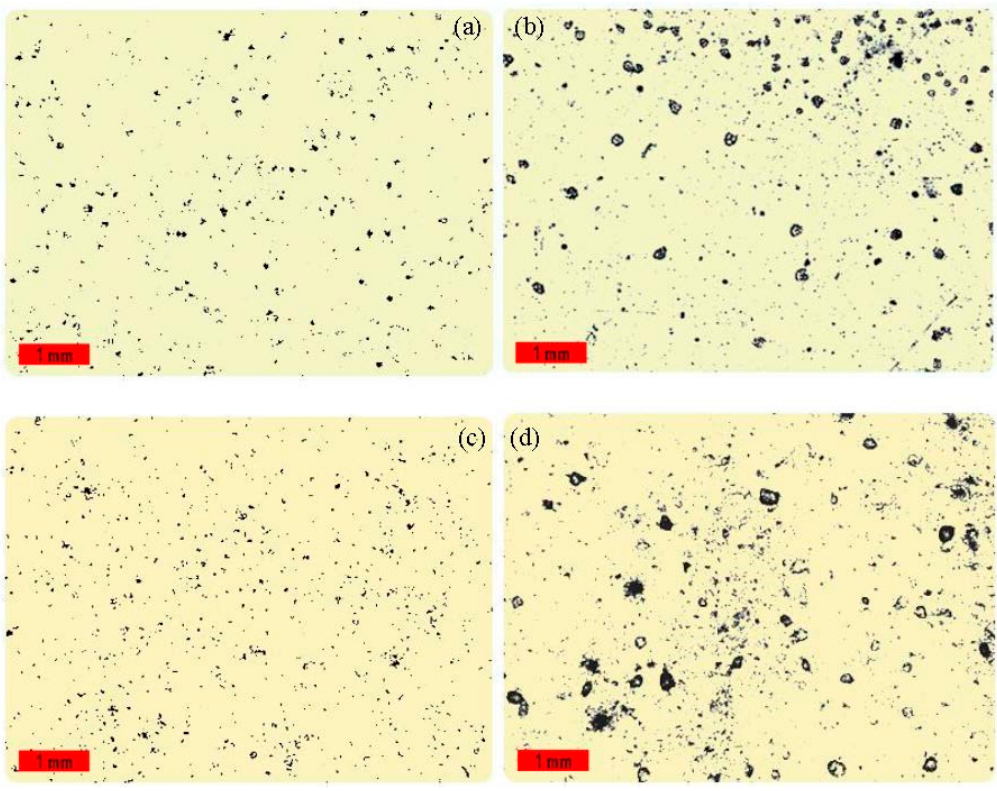
Figure 10. Optical photographs of ( a ) untreated xPVAc/EMDI; ( b ) untreated xPVAc/ p -MDI; ( c )